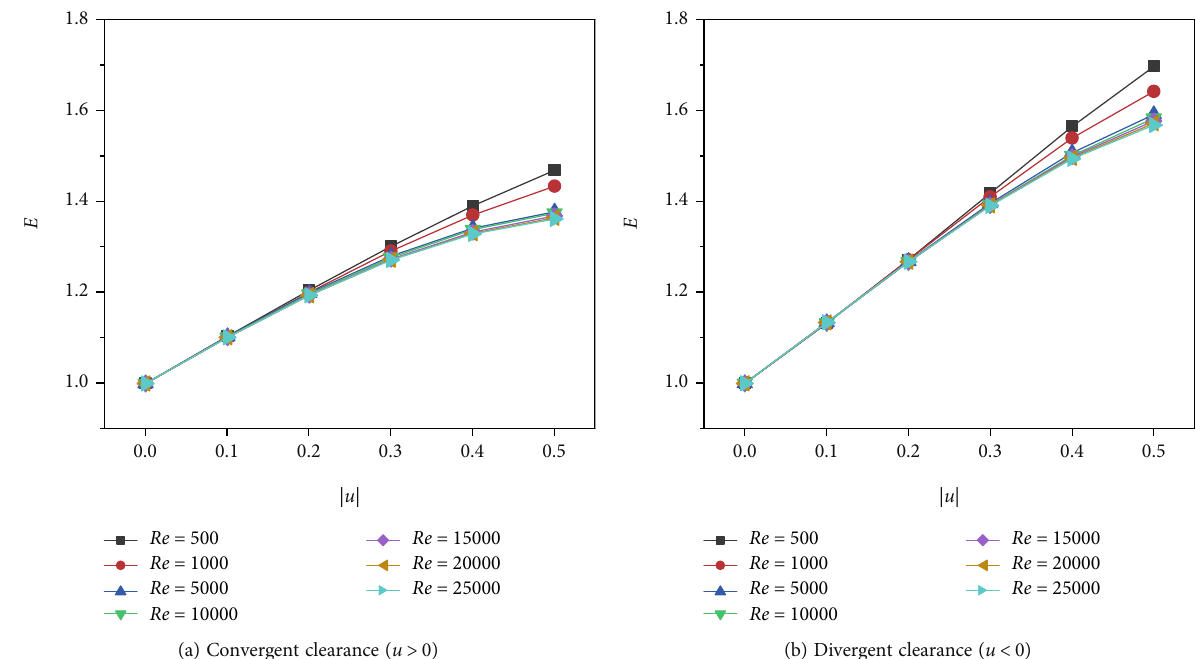
= 0 : 23 , and C = 0 : 067 ). U